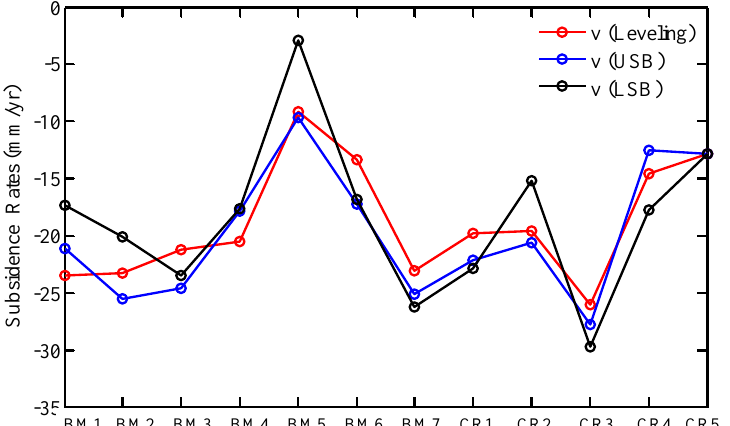
Table 1. Comparison between subsidence rates derived by leveling and the USB-/LSB-based TCP solutions at seven BMs and five CRs. (unit: mm/yr)